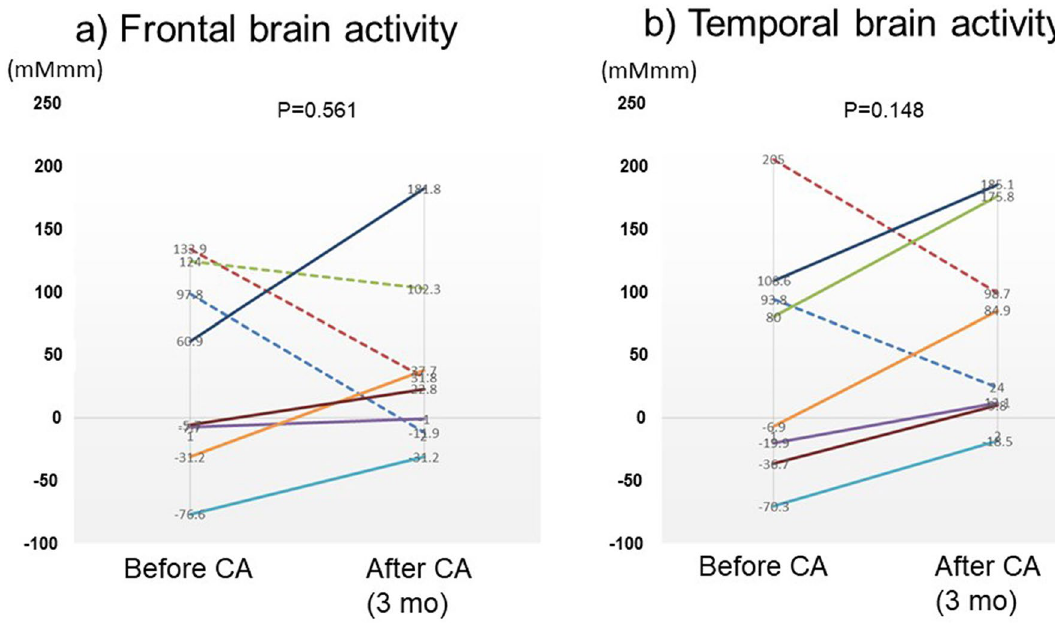
Figure 4. A solid line indicates a patient who showed improvement in brain activity, and a dotted line indicates a patient who showed no improvement. Changes in frontal and temporal brain activities before and after catheter ablation (CA) in the 8 patients with persistent atrial fibrillation (AF) who kept sinus rhythm after CA. Of these 8 patients, 5 (62.5%) presented improved frontal brain activity, and 6 (75.0%) presented improved temporal brain activity after